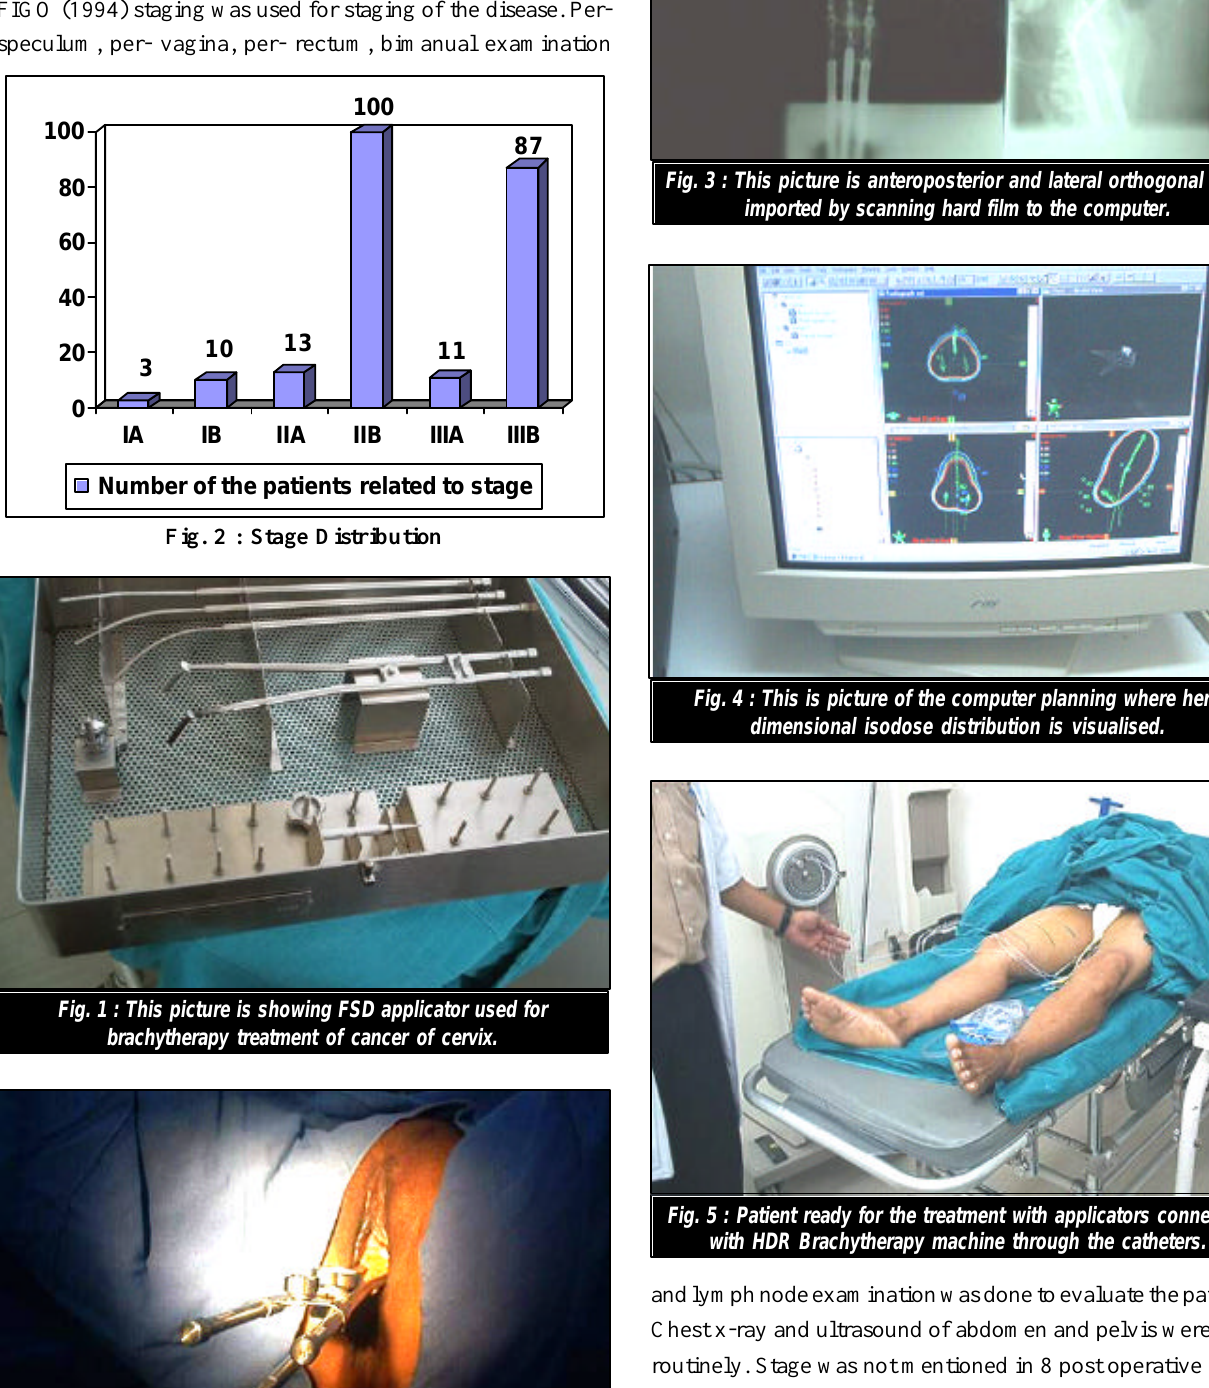
Fig. 3 : This picture is anteroposterior and lateral orthogonal films imported by scanning hard film to the computer.